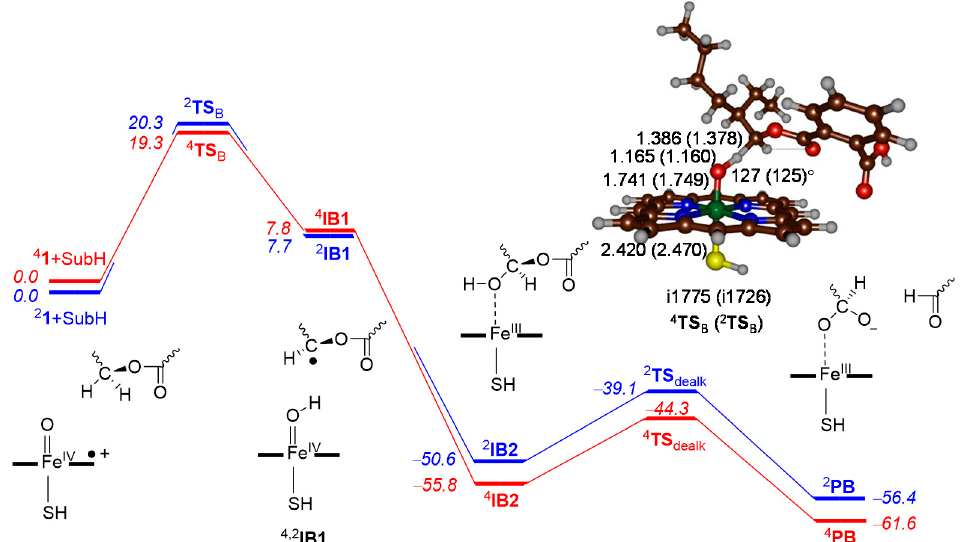
Figure 6. Potential energy landscape (B3LYP/BS1 optimized) of phthalate O-dealkylation by P450 CpdI. Relative energies contain zero-point corrections and are taken from B3LYP/BS2//B3LYP/BS1 in kcal·mol − 1 . Optimized geometries give bond lengths in angstroms, the Fe–O–C angle in degrees and the imaginary frequency in the transition state in cm − 1 .